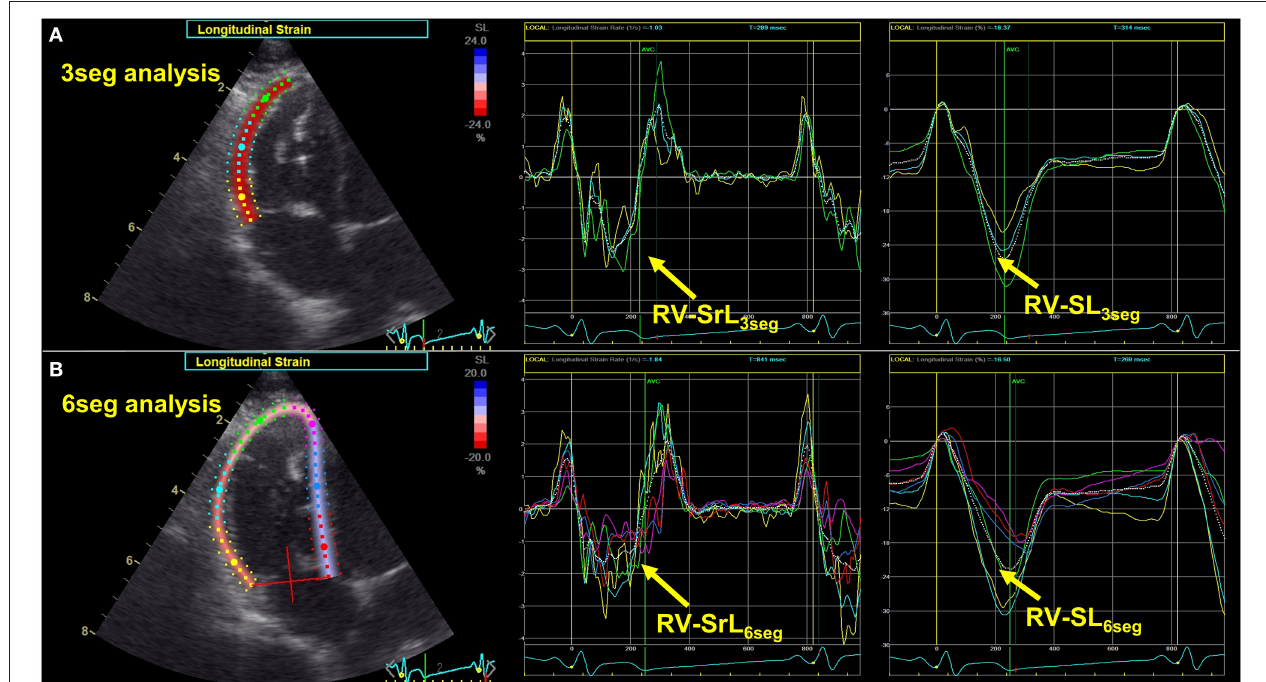
FIGURE 1 | Two-dimensional speckle tracking echocardiography-derived right ventricular longitudinal strain and strain rate (RV-SL and RV-SrL, respectively). (A) RV-SL and RV-SrL of the right ventricular free wall (RV-SL 3seg and RV-SrL 3seg , respectively). (B) RV-SL and RV-SrL of the global right ventricle (RV-SL 6seg and RV-SrL 6seg , respectively).